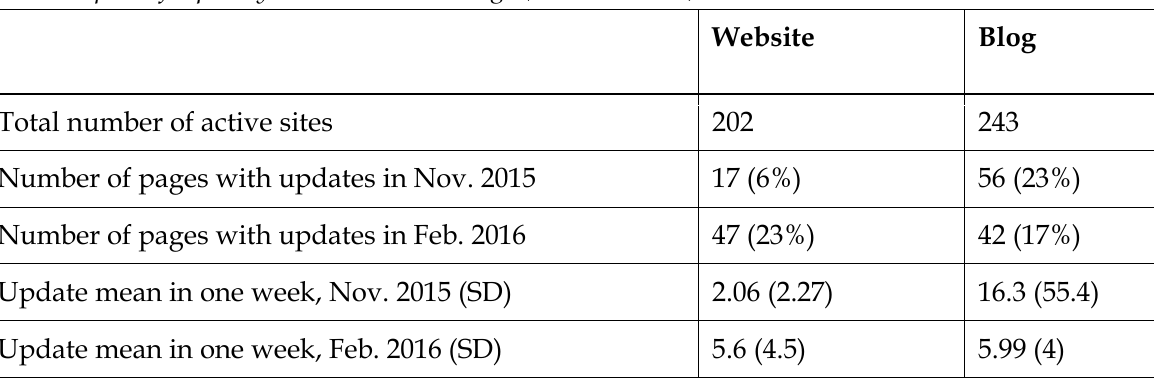
Table 2: Update frequency on websites and blogs (source: author)